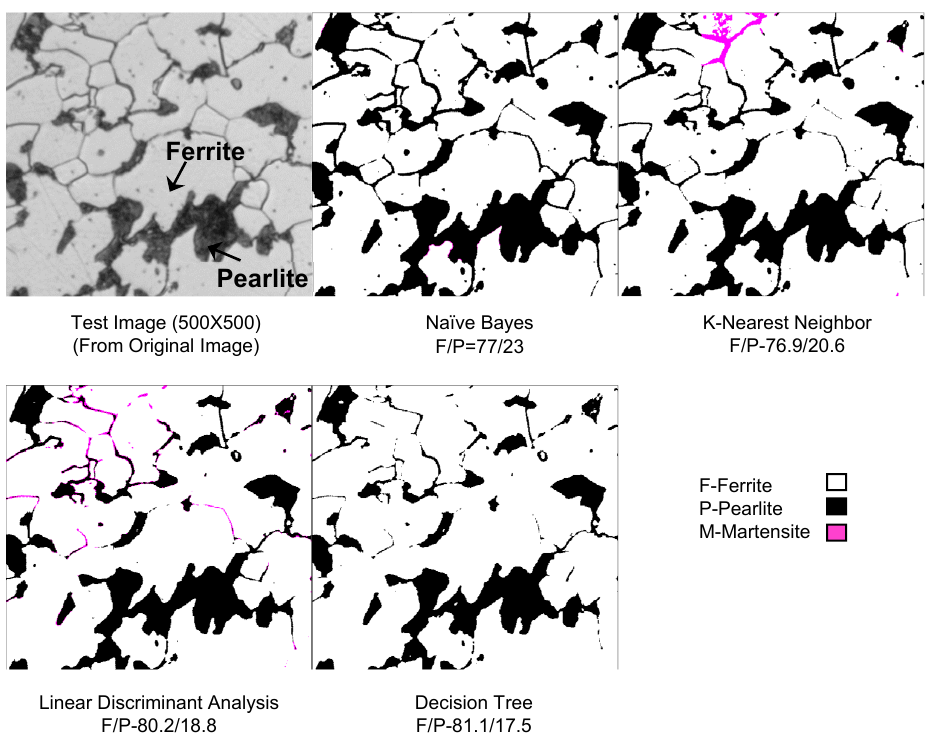
Figure 7. The microstructure of ASTM A36-900AC and machine learning-based metallurgical phase identification. All four classifiers predicted the phases accurately.